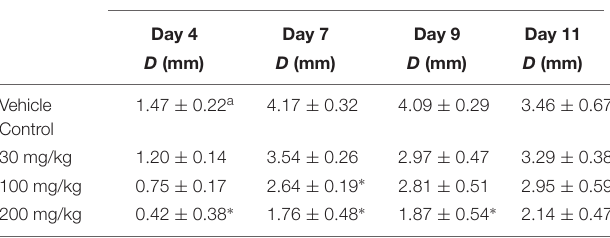
TABLE 1 | Effect of gemcabene on joint